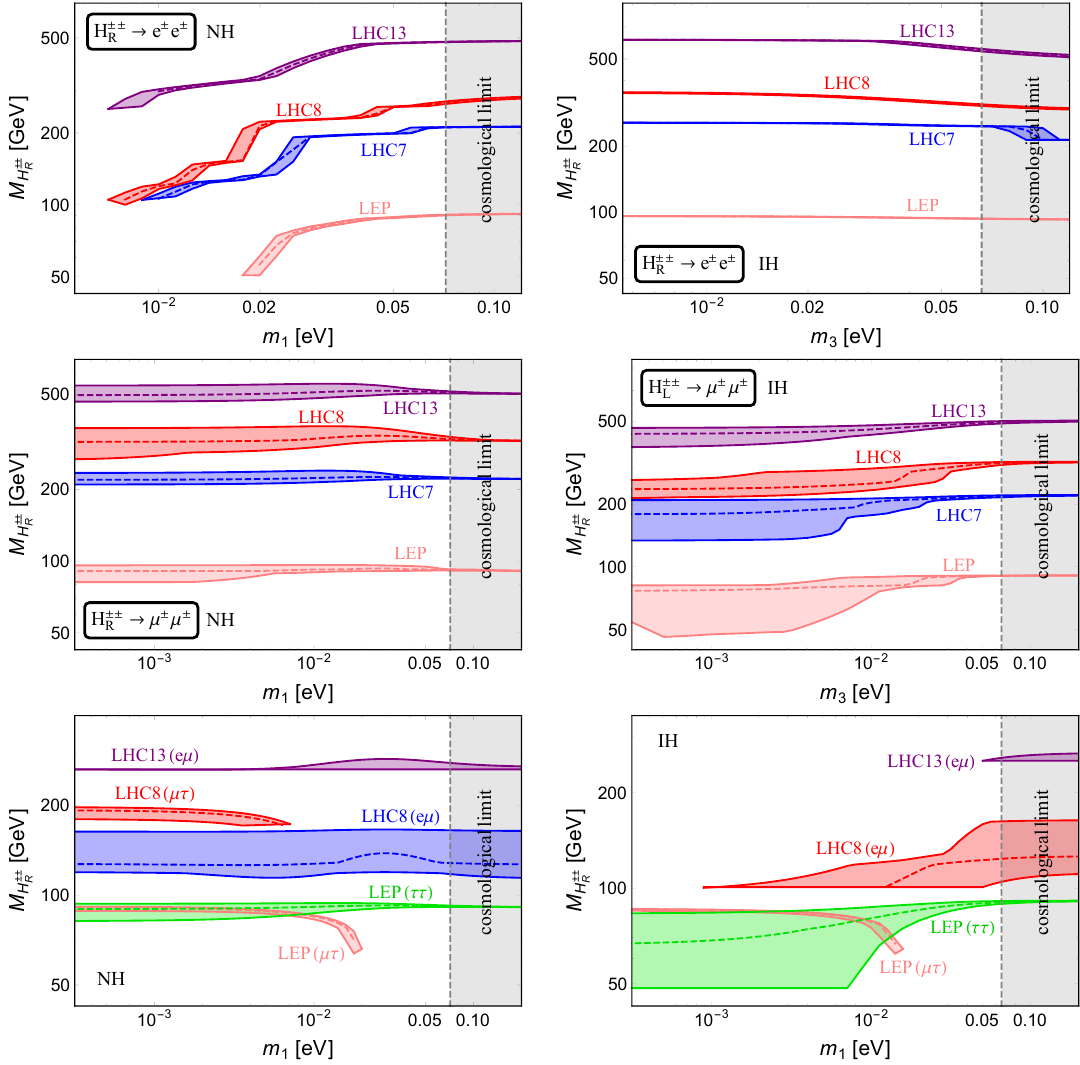
Figure 13 . Same-sign dilepton lower limits on M in the LRSM from the data in (cid:12)gure 12 for H (cid:6)(cid:6) R di(cid:11)erent (cid:13)avor combinations H (cid:6)(cid:6) ! ‘ (cid:6) ‘ (cid:6) , as functions of the lightest neutrino mass for NH (left) (cid:11) R (cid:12) and IH (right). The dashed curves correspond to the central values of the neutrino data in table 1, and the colorful bands are due to the 3 (cid:27) uncertainties. The gray shaded region is excluded by the cosmological constraint on the sum of light neutrino masses P m i < 0 : 23 eV [99]. i